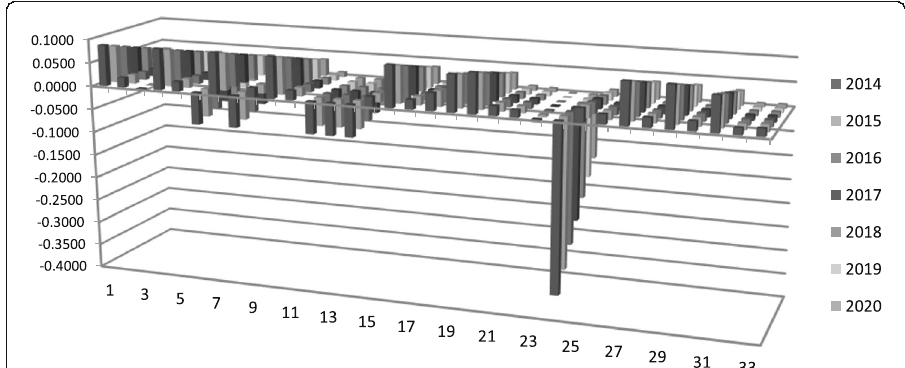
Fig. 4 Percentage change in prices of financial commodities from the